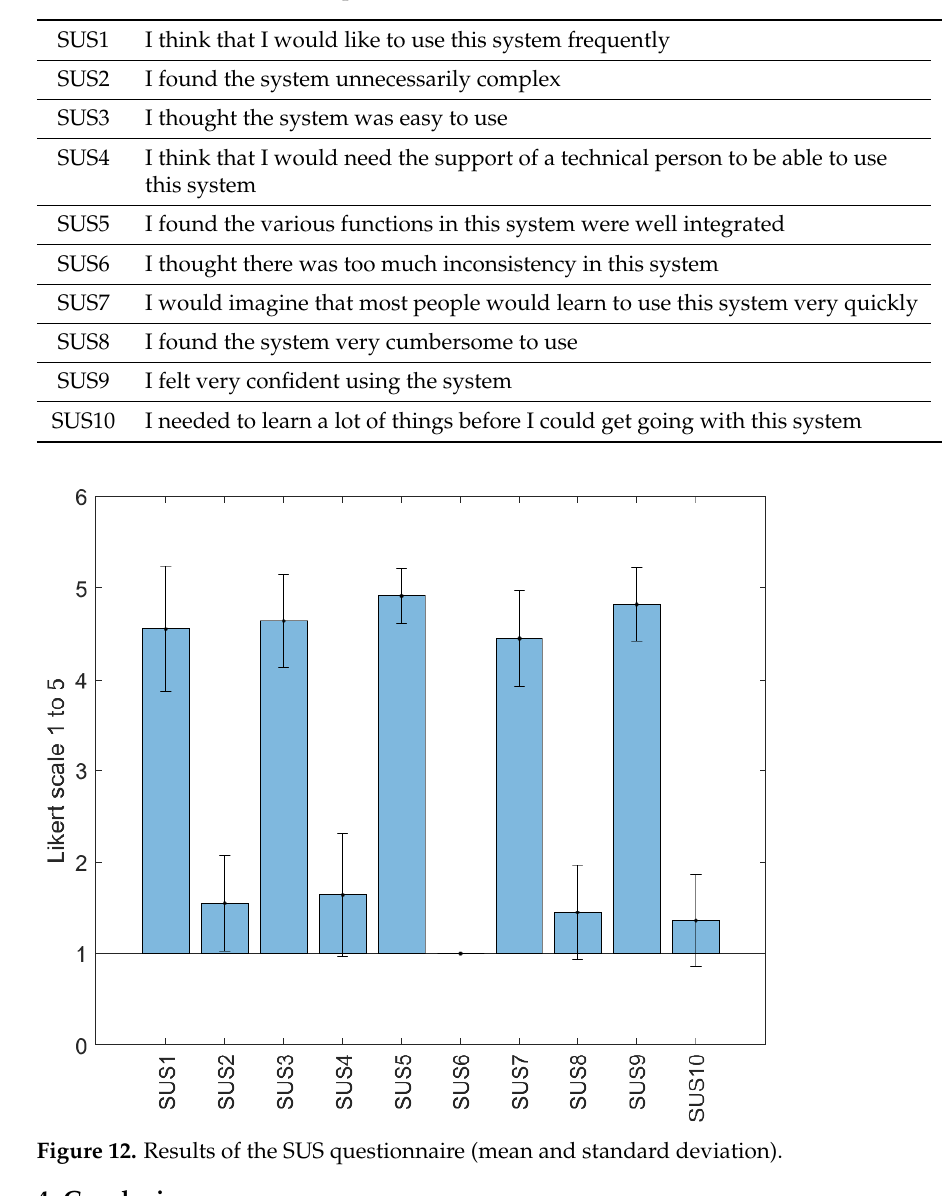
Table 3. Questions of the SUS questionnaire [80].